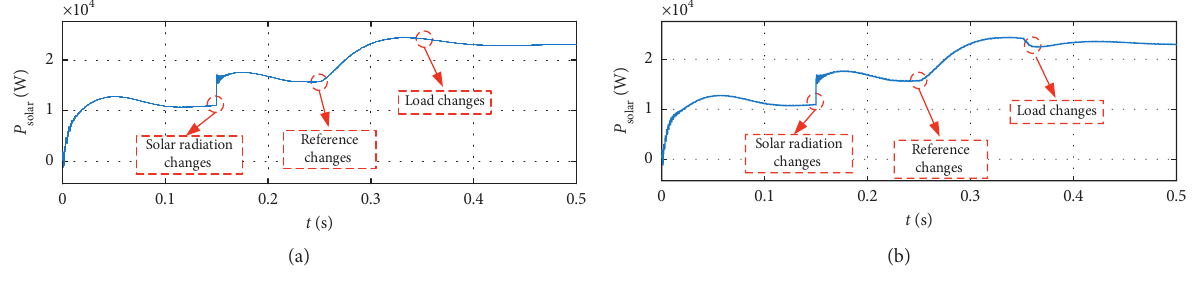
Figure 13: Output power of the PV system. (a) PV. (b) PV